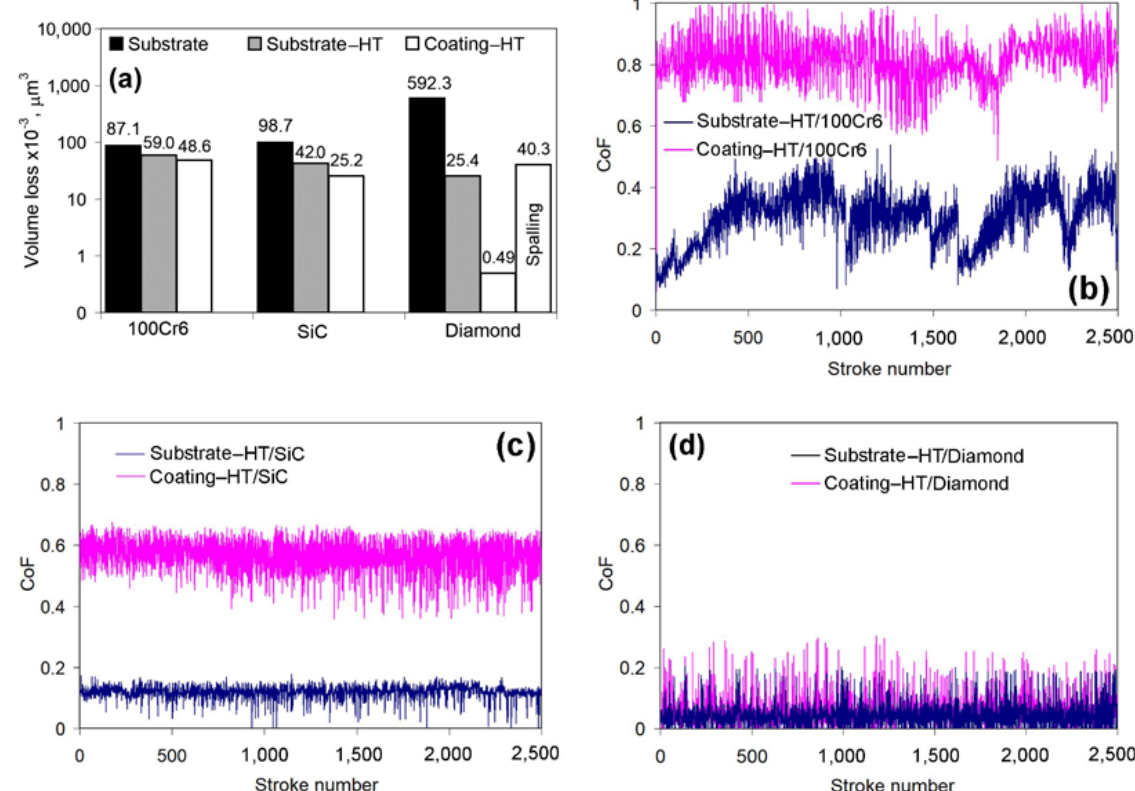
Figure 7. Dry-sliding wear characteristics of the substrate, the substrate-HT, and the heat-treated coating. ( a ) Consolidated data on specimens’ volume losses. ( b ) CoF variation for testing against 100Cr6 steel ball. ( c ) CoF variation for testing against SiC ball. ( d ) CoF variation for testing against diamond cone.